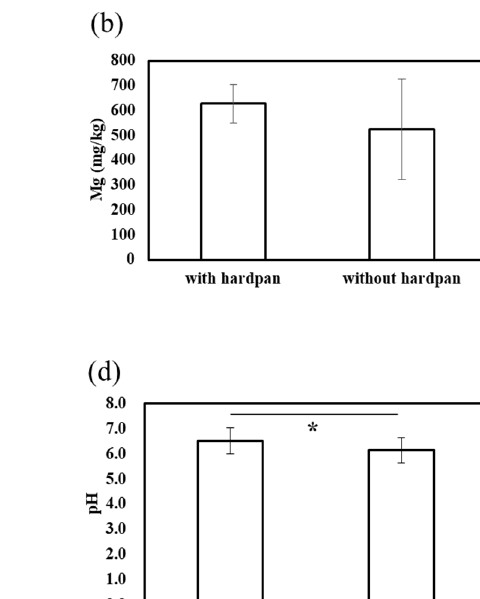
Figure 6. Mineral contents in two groups categorized by hardpan formation. ( a ) Total nitrogen, ( b )